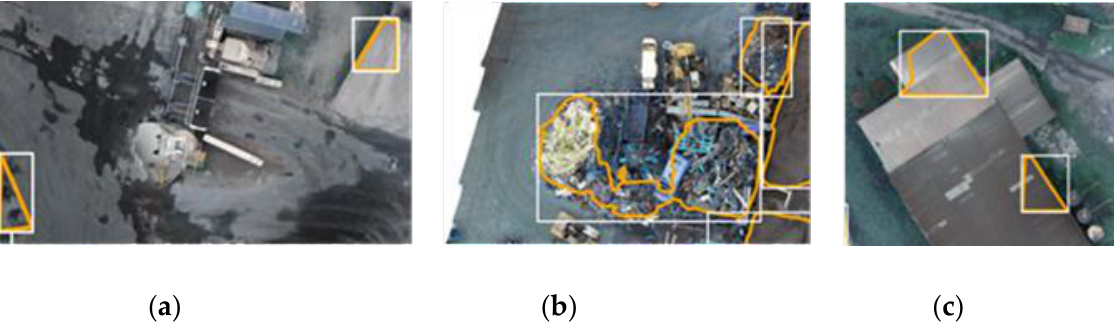
Figure 23. Frequent types of false positives. ( a ) small predictions at the outer region of the sliding window; ( b ) piles of crushed metal from a neighboring scrapyard; ( c ) edges of roofs.